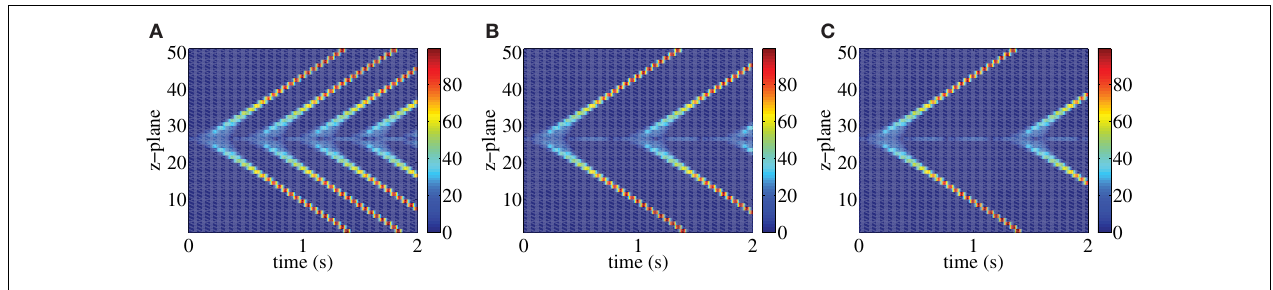
indicate substantial Ca 2 + release site activity, while cool colors correspond to lesser Ca 2 + release activity. Other parameter values as in Table 1 and σ = 8.5 µ M µ m 3